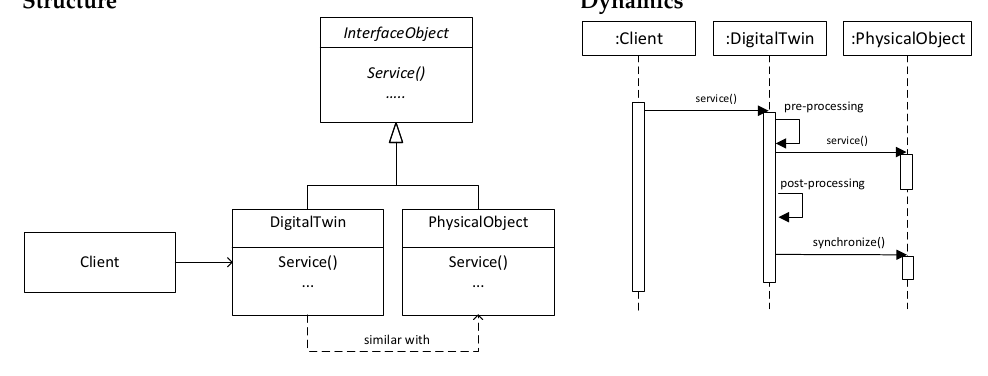
Figure 11. Digital Proxy Pattern.